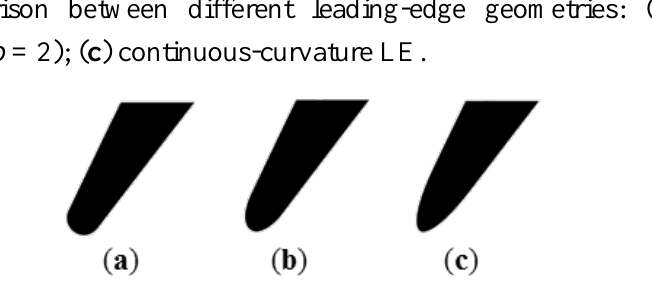
Figure 8. Comparison between different leading-edge geometries: ( a ) circular LE;